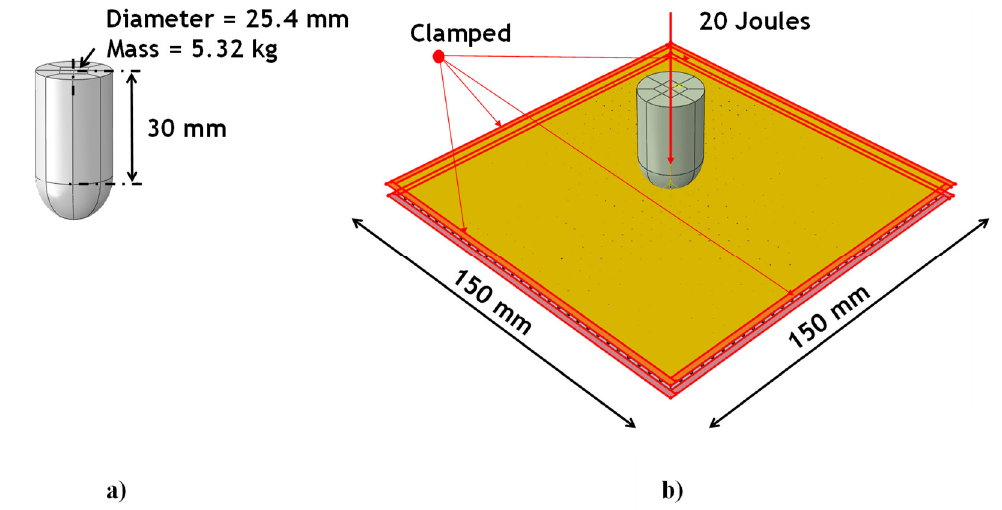
Figure 8. FE model used to perform the sensitivity analysis: ( a ) impactor dimension and mass; ( b ) panel dimensions and BCs.